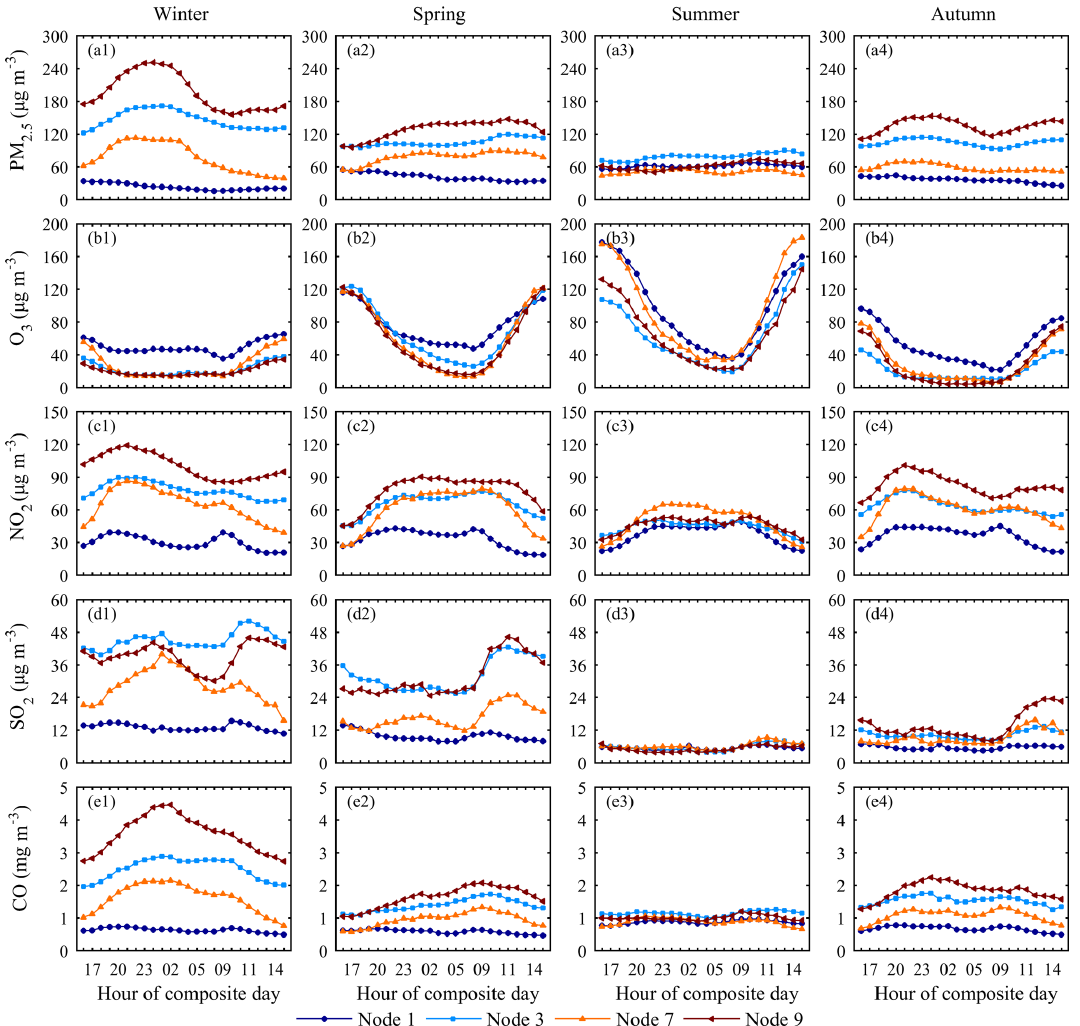
Figure 6. Mean hourly composites of (a) PM 2 . 5 , (b) O 3 , (c) NO 2 , (d) SO 2 and (e) CO in Beijing for the four typical ABL types separately in (1) winter, (2) spring, (3) summer and (4)